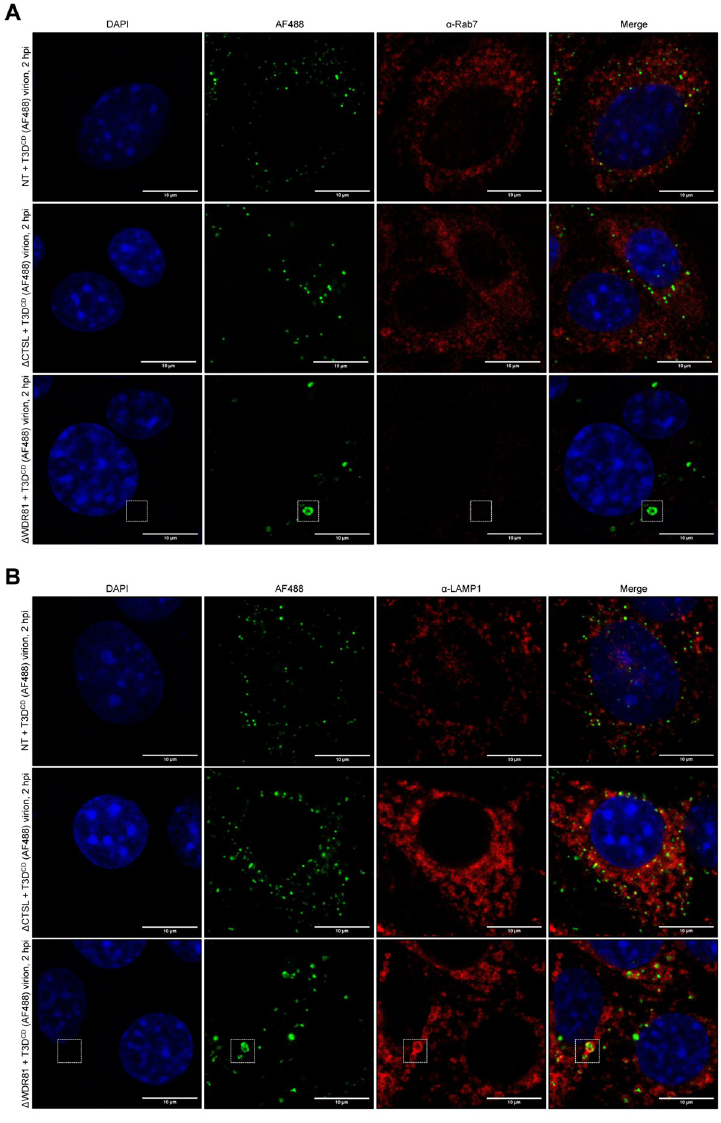
Fig 8. Colocalization of T3D CD (AF488) virions with Rab7 and LAMP1 in WDR81-deficient cells. (A and B) NT, Δ CTSL, and Δ WDR81 cells were infected with T3D CD (AF488) at 10,000 virions/cell. At 2 h post infection (hpi), the infected monolayers were fixed, stained with an anti-Rab7 (A) or anti-LAMP1 (B) primary antibody and with DAPI, mounted, and imaged by confocal microscopy. The images were obtained using a X63 oil-immersion objective and processed using ImageJ software [42]. The DAPI signal is false colored in blue, the AF488 signal is false colored in green, and the Rab7 (A) or LAMP1 (B) signal is false colored in red. The white boxes highlight large virus puncta and/ or LAMP1 donut-shaped structures. The scale bars represent 10 μ m (n = 3 biological replicates; results from 1 representative experiment are